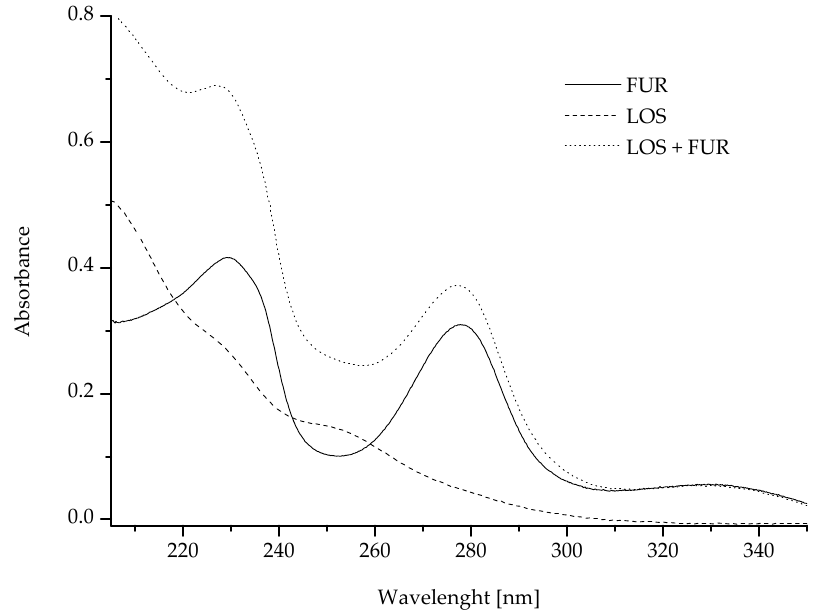
Figure 5. The absorption spectra of LOS, FUR and drugs mixture ([LOS] = [FUR] = 1 × 10 − 5 M; molar ratio LOS:FUR 1:1). Table 2. The average values of maximum absorbance of LOS, FUR and drugs mixture at the maxi-